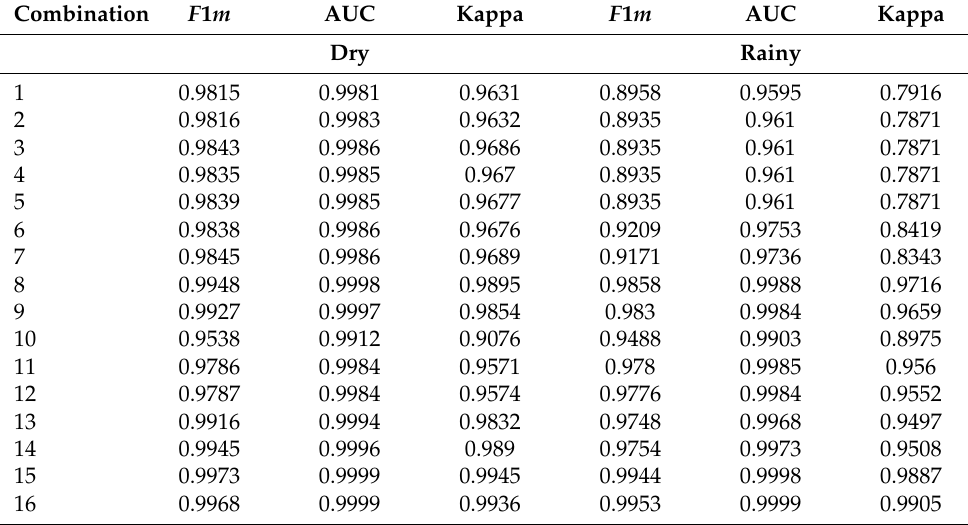
Table 4. Values of performance indicators obtained using the GB algorithm for all combinations for the dry and rainy seasons.